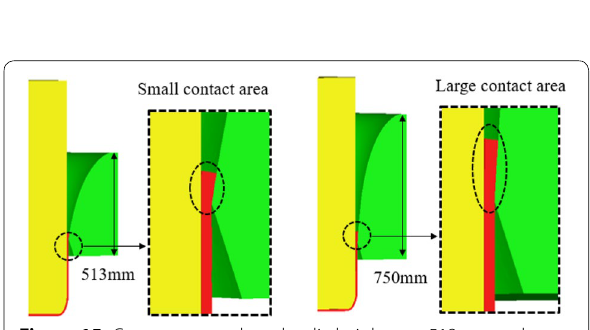
Figure 15 Contact areas when the die heights are 513mm and